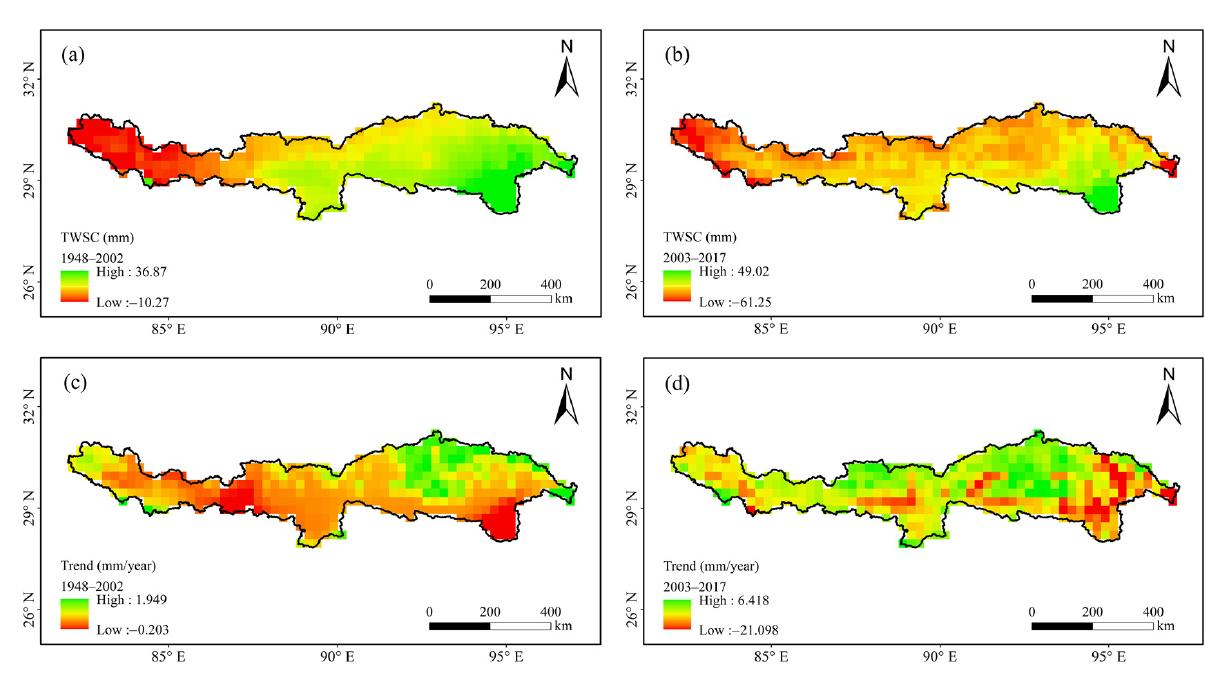
Figure 8. Spatial distribution of multi-year average value of TWSC ( a , b ) and variation trends of multi-year average of TWSC ( c , d ) before and after 2002, respectively.